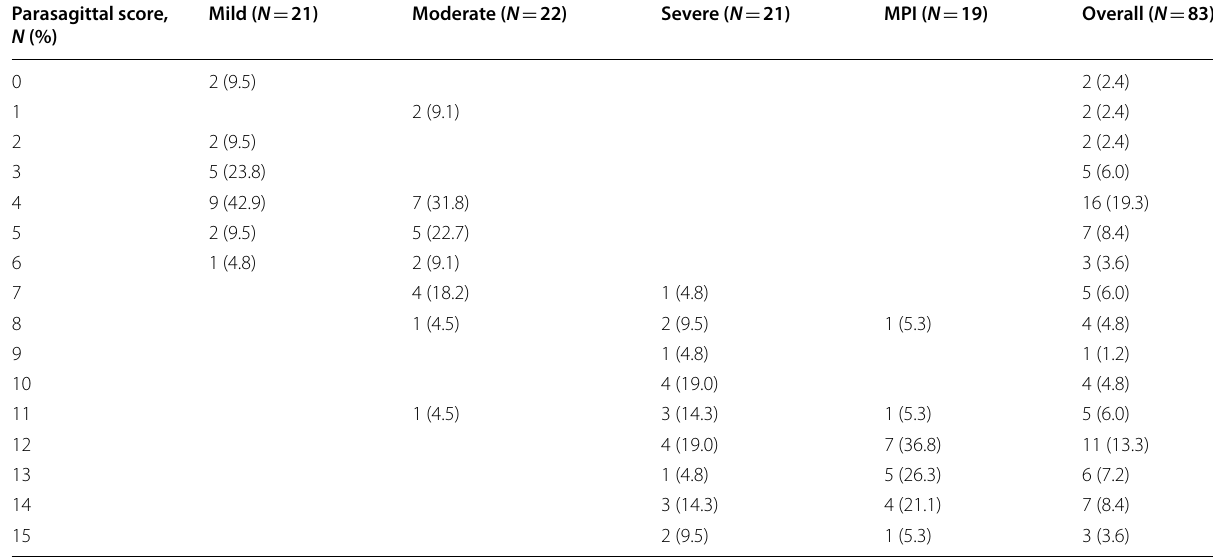
Table 3 Distribution of the parasagittal score between sub‑groups